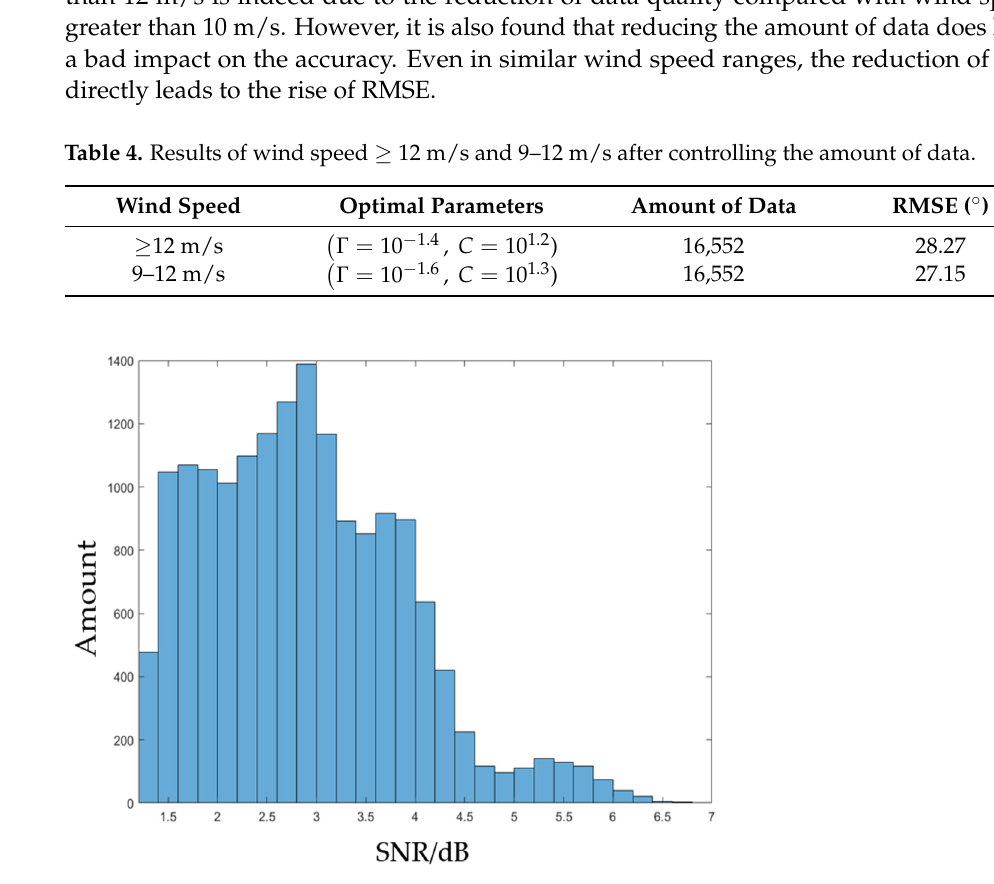
Figure 13. The number distribution of SNR with wind speeds greater than 12 m/s.